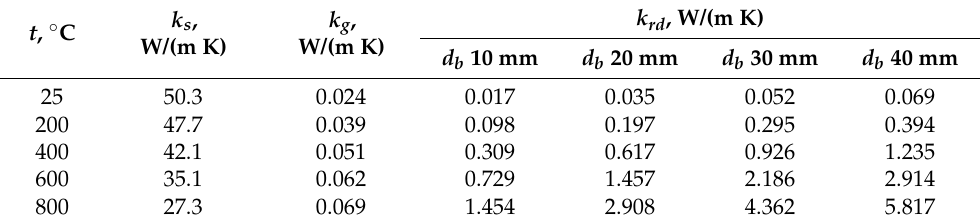
Table 2. The values of k s , k g , and k rd coefficients for the chosen temperatures.